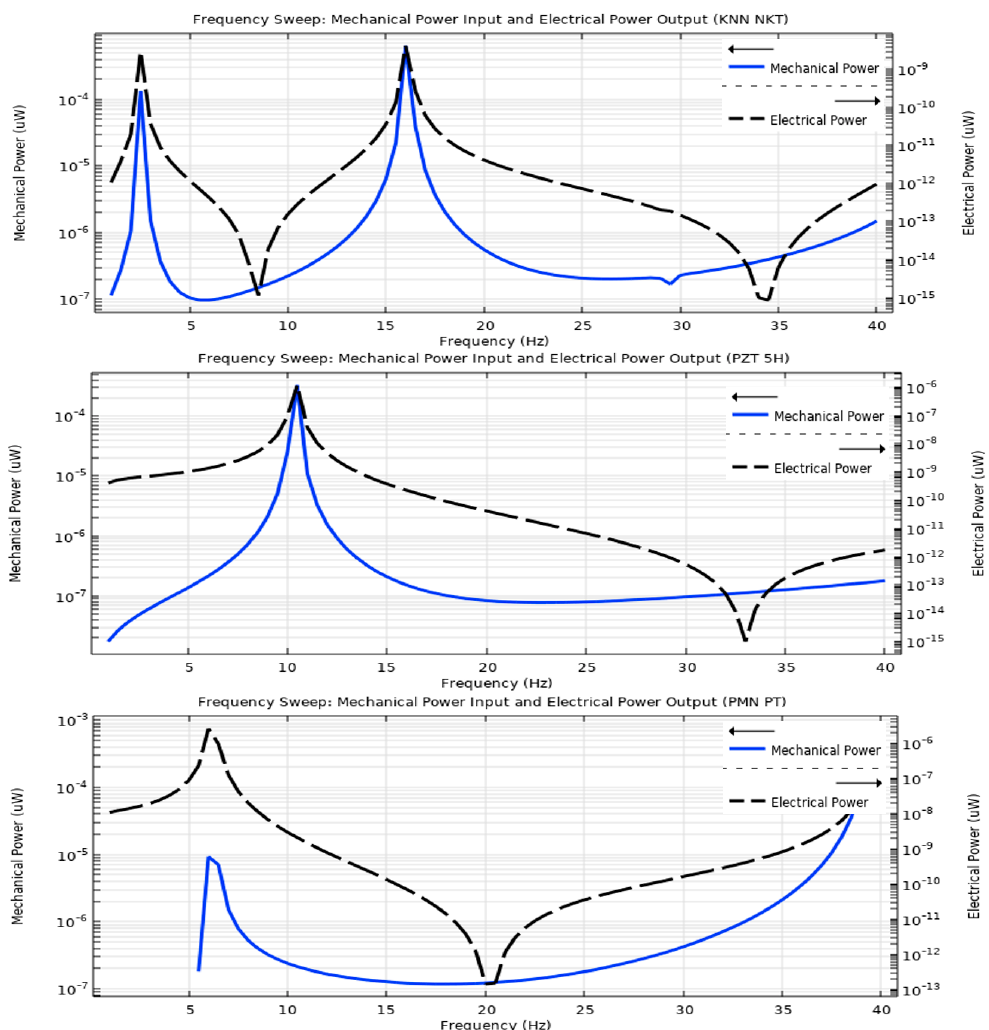
Figure 5. The transverse vibration mechanical power input vs. electrical power output.